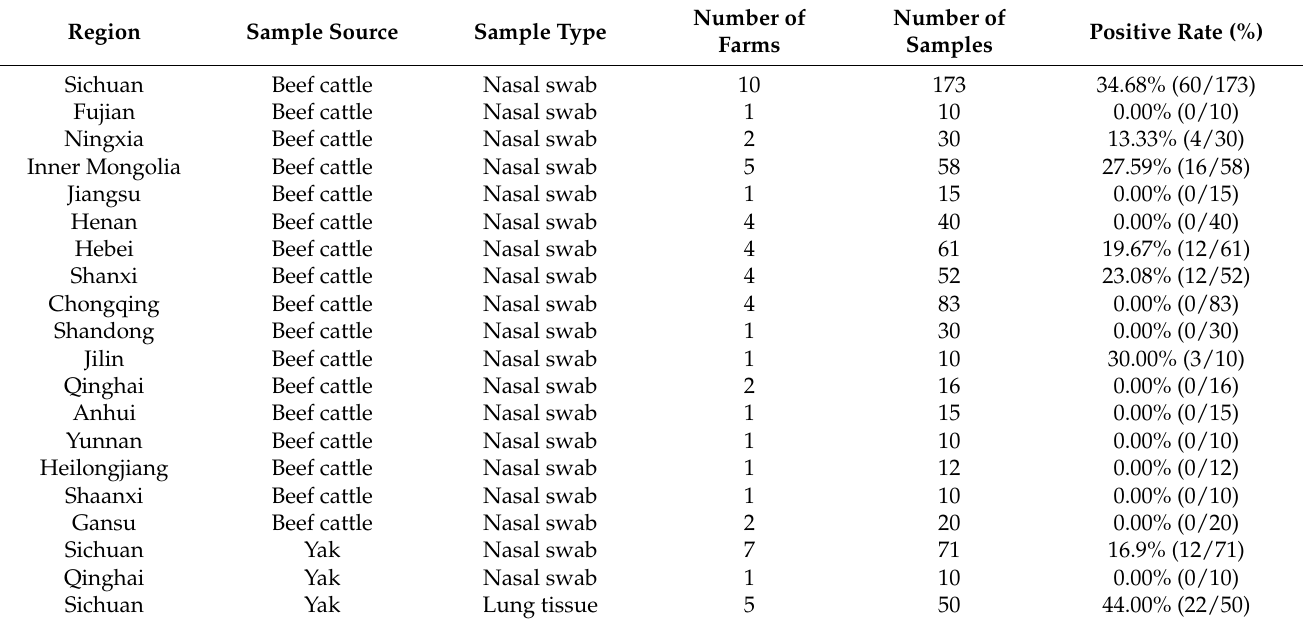
Table 1. Prevalence of BPIV3 in respiratory samples from different regions of